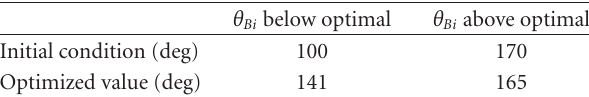
Figure 10: Mass capture for inlet with conductivity σ = 1.5 mho/m. Results are shown for (a) coincident ionization and (b) stationary ionization. Table 3: Table of optimized magnetic field angle for coincident ionized